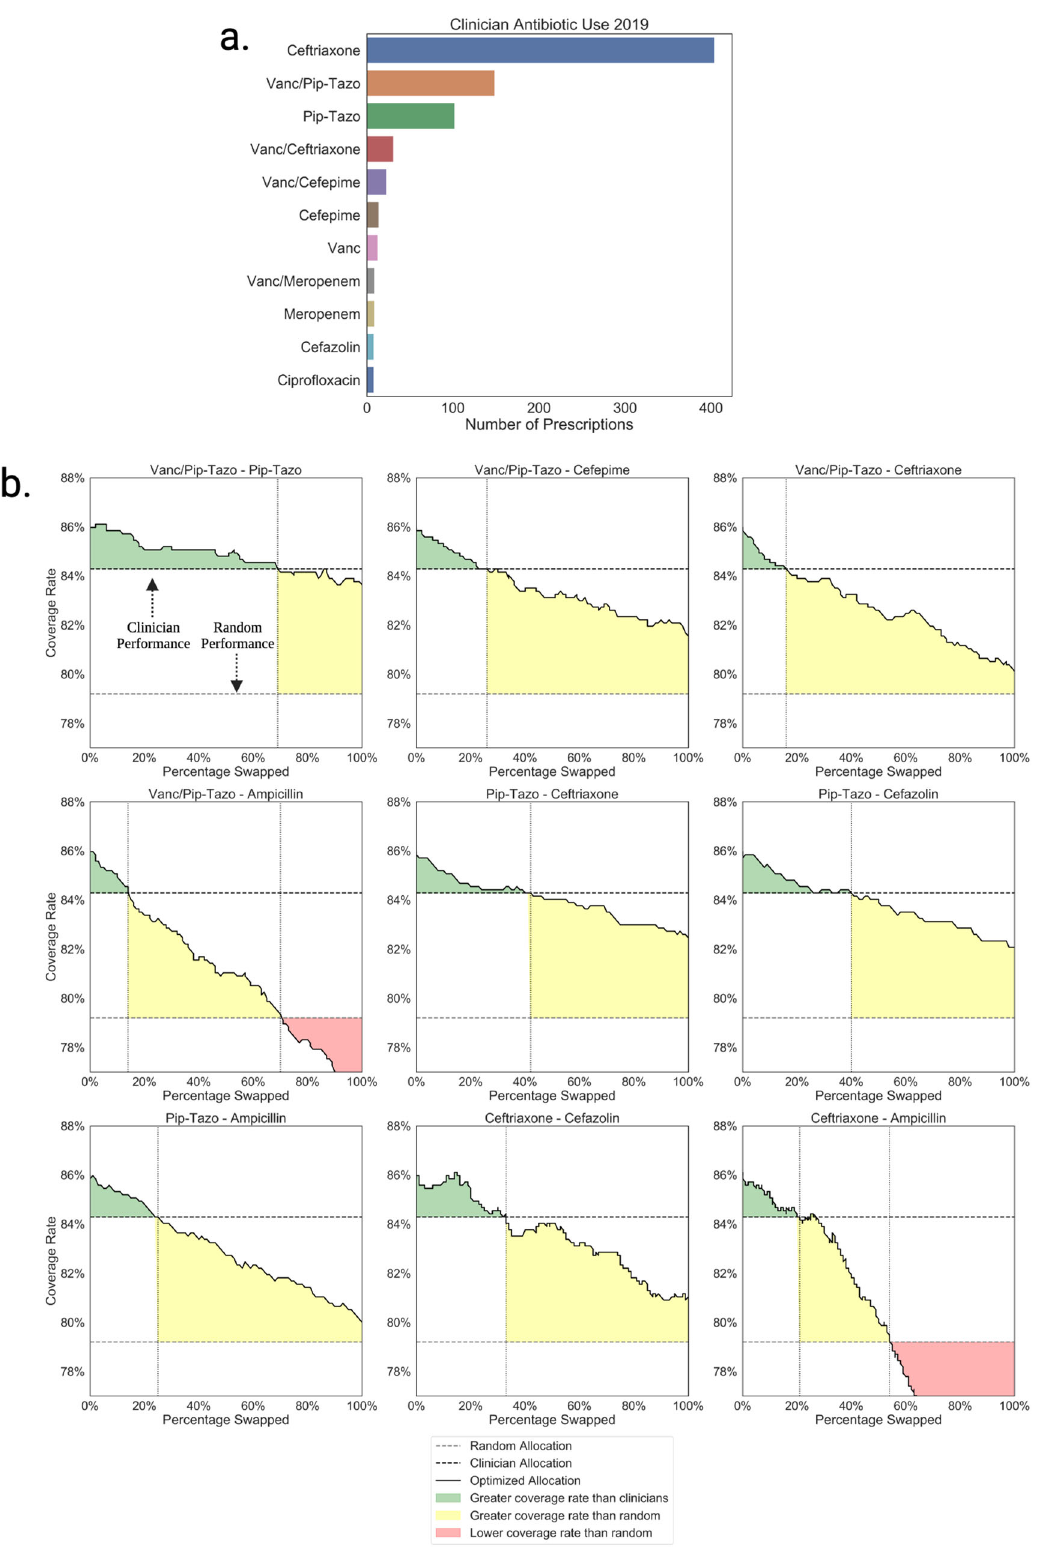
Fig. 4 Personalized antibiogram coverage rate as a function of the antibiotic budget parameters. a Held out Stanford test set of emergency hospital admissions treated with one of the twelve most common empiric IV/IM antibiotic selections. b Antibiotic sweep simulations showing the trade off between coverage rate and broad-spectrum antibiotic use when antibiotic selection is optimized with personalized antibiograms. For example, the plot titled “ Vanc/ Pip-Tazo - Pip-Tazo ” illustrates the change in coverage rate as more historical prescriptions for Vancomycin + Piperacillin-Tazobactam (Vanc/Pip-Tazo) are exchanged for Pip-Tazo, prioritized by personalized antibiogram predictions. On the far left of the plot, starting with 0 change in the actual amount of antibiotics prescribed, the fi gure illustrates the green region where personalized antibiograms could potentially have achieved an even better antibiotic coverage rate than the actual prescriptions by clinicians (represented by the dark dashed line) with equal or fewer Vanc/Pip-Tazo. COMMUNICATIONS MEDICINE| (2022) 2:38